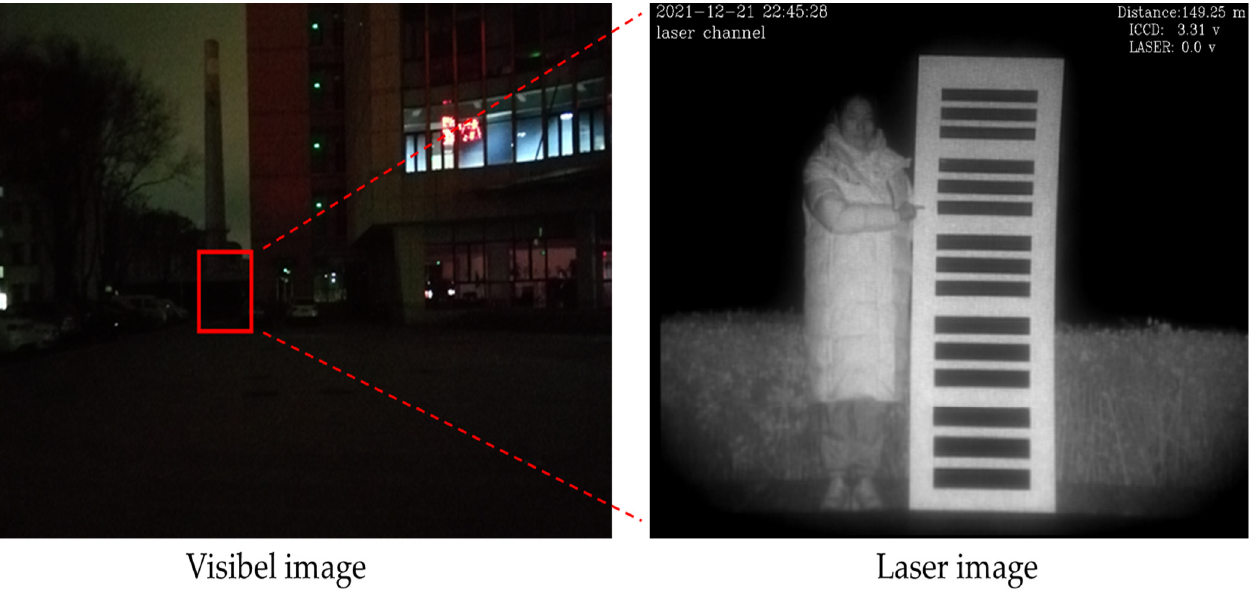
Figure 1. Visible image and laser image.